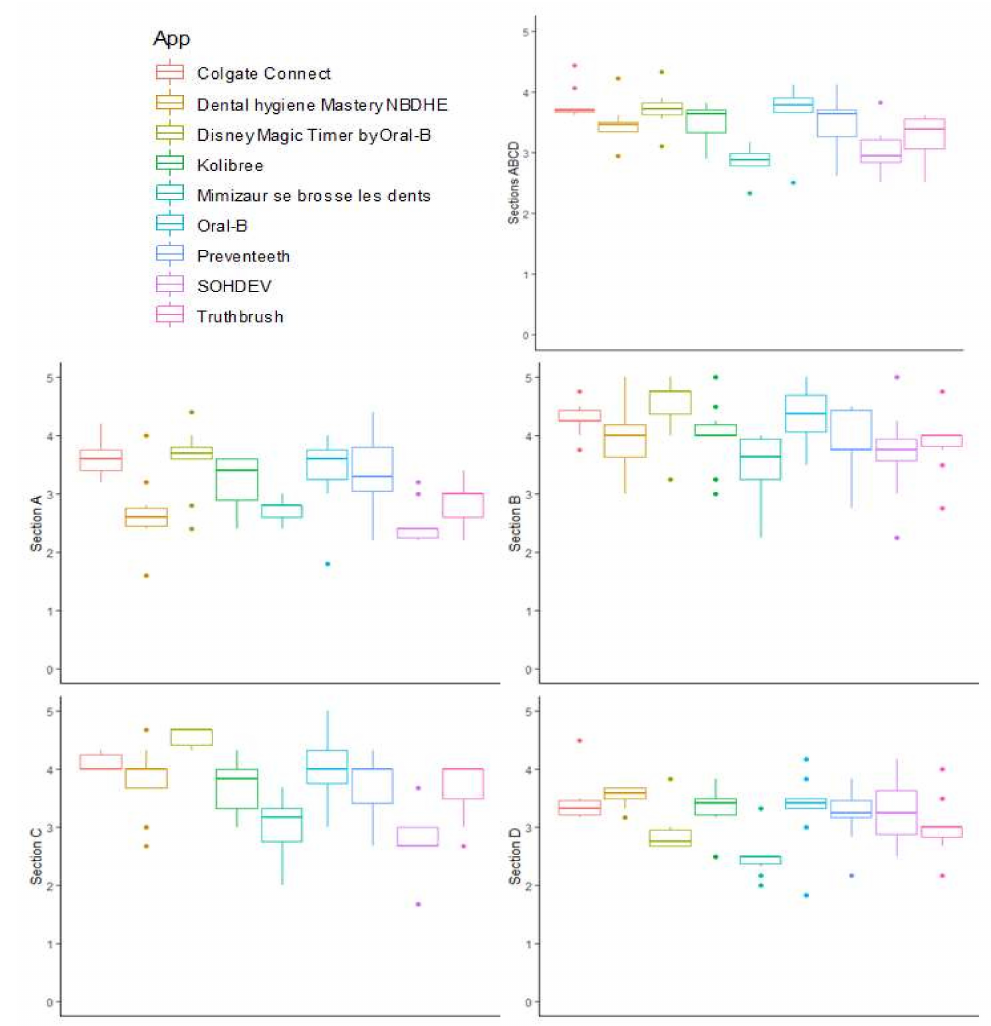
Figure 2. Qualitative evaluation of oral-health-related mobile apps. Section A: engagement; section B: functionality; section C: aesthetics; section D: information.